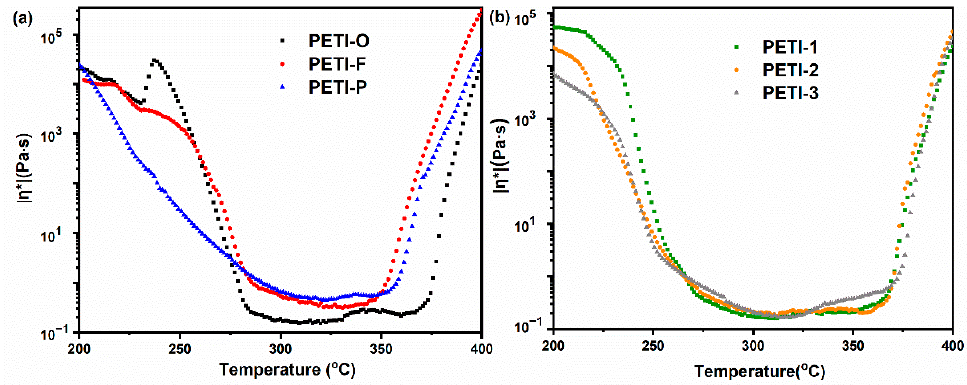
Table 2. Complex viscosity data of PETIs.